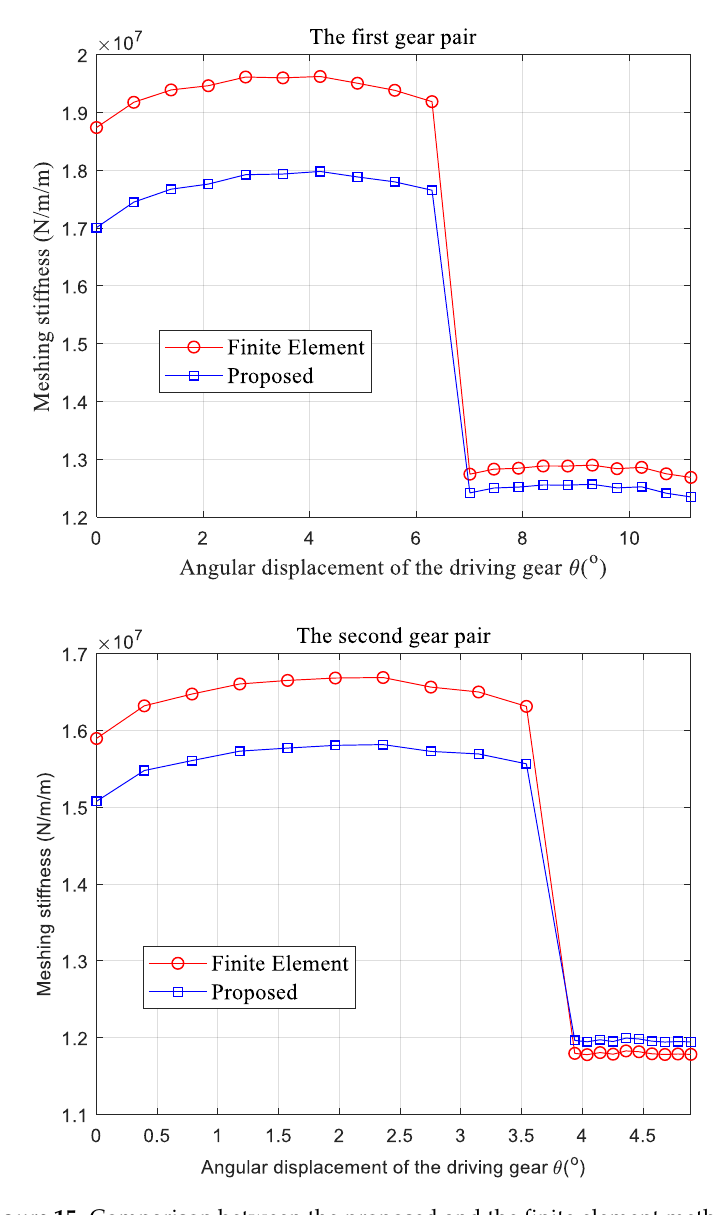
Figure 15. Comparison between the proposed and the finite element method.